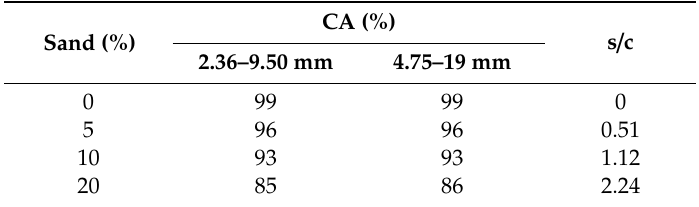
Table 2. ACI percentages of sand and their s / c ratio.